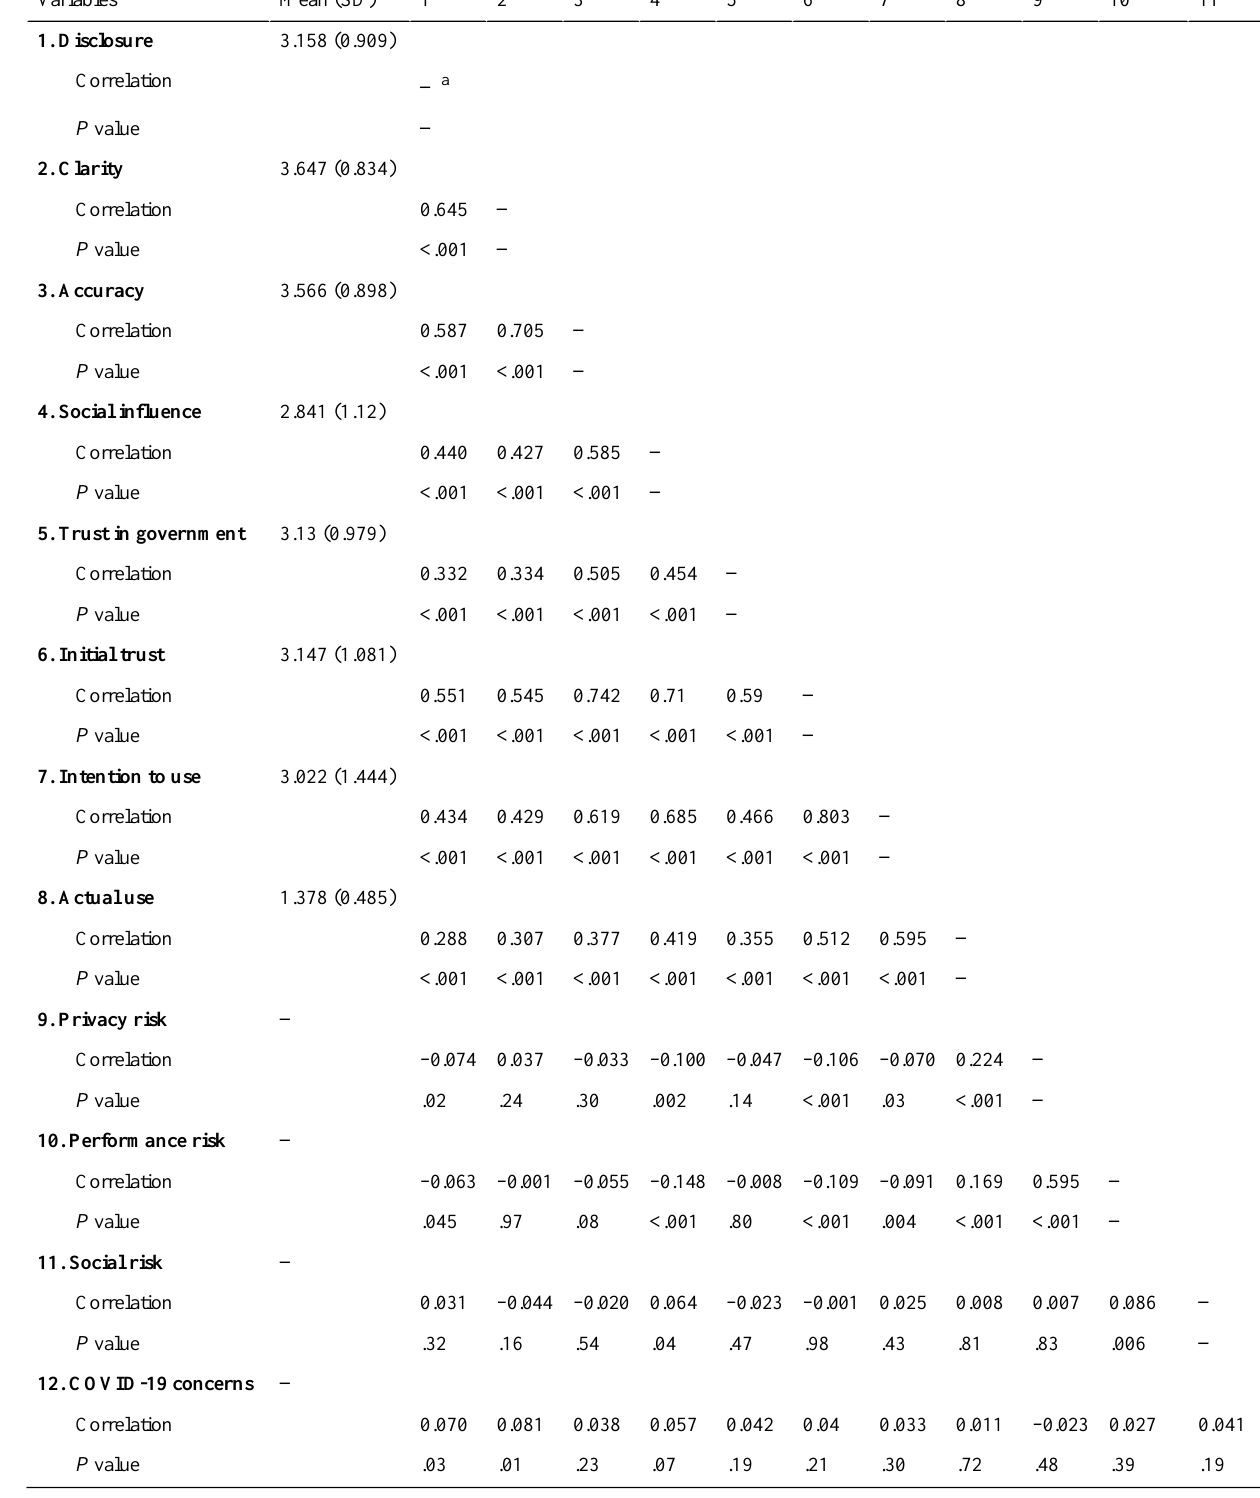
Table 3. Mean, SD, and